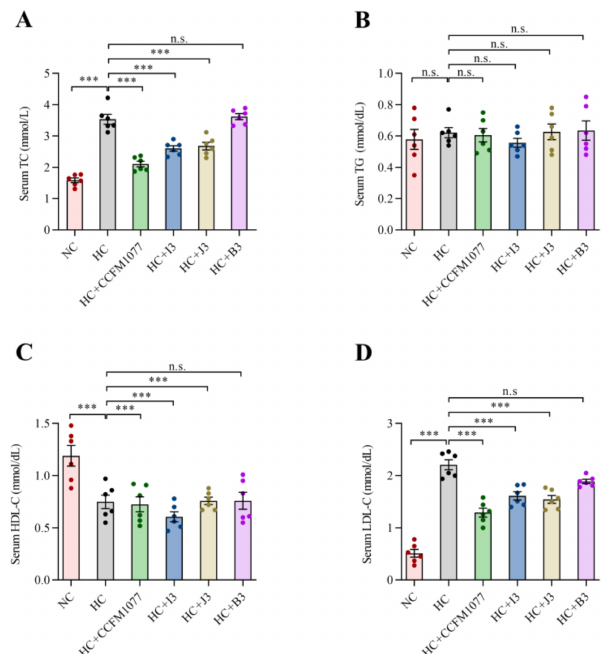
Figure 2. The effects of four B. longum strains on serum lipid levels of ( A ) TC, ( B ) TG, ( C ) HDL-C and ( D ) LDL-C in rats with hypercholesterolemia. *** represents p < 0.001, n.s represent non-significant with p >